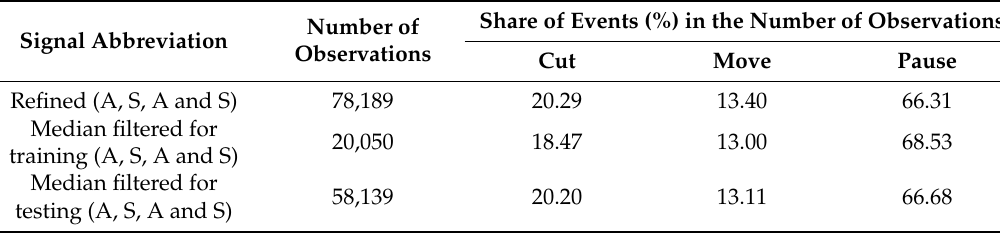
Table 2. Share of the true events in the signals